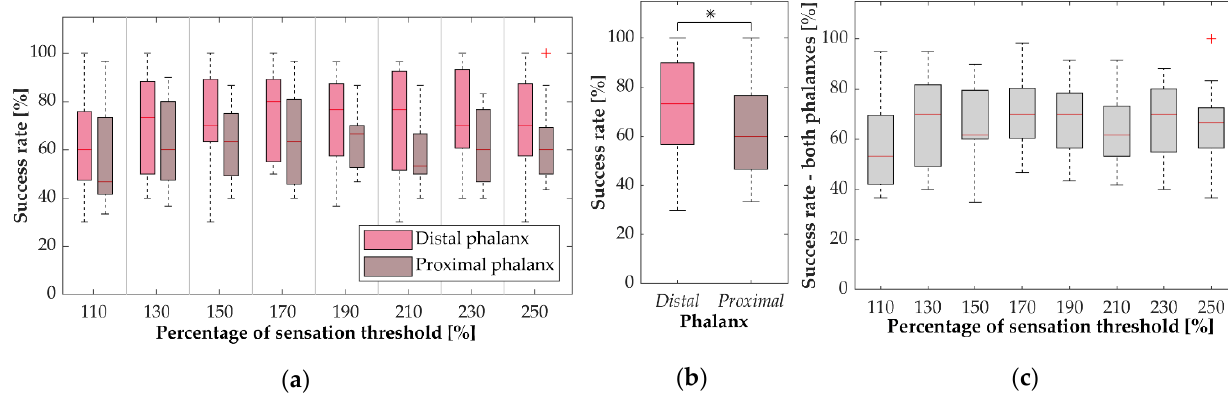
Figure 4. ( a ) Success rate in spatial discrimination obtained for different current amplitudes for the distal phalanx (pink) and proximal phalanx (brown); ( b ) Main effect of phalanx—the success rate for each phalange averaged across current amplitude levels; ( c ) Main effect of current amplitude—success rate for each current amplitude level averaged across the two phalanges. The red line, box, whiskers and red mark indicate the median, interquartile range upper/lower boundaries and outlier, respectively. Asterisks indicate significant differences (*: p < 0.05).